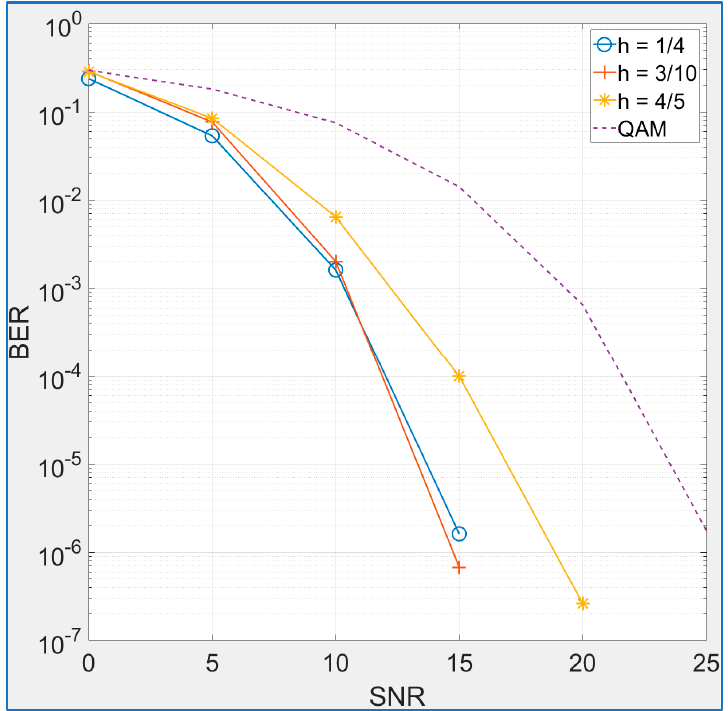
Figure 17. BER performance of CPM-GFDM vs. QAM-GFDM with J = 8 for zero forcing receiver over frequency-selective channels.